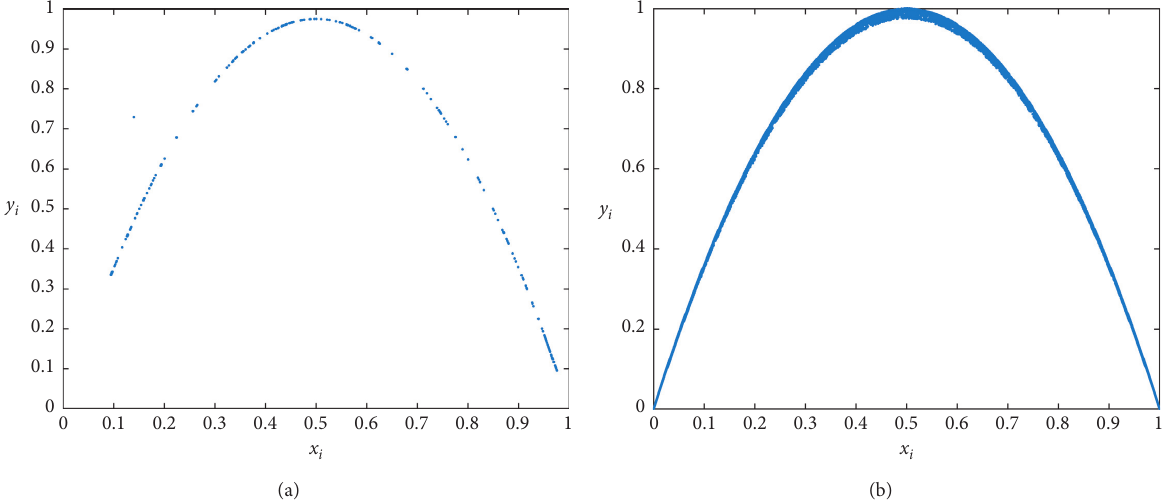
Figure 2: The phase diagrams of two maps. (a) Digital logistic map; (b) iteration-time combined digital logistic map.